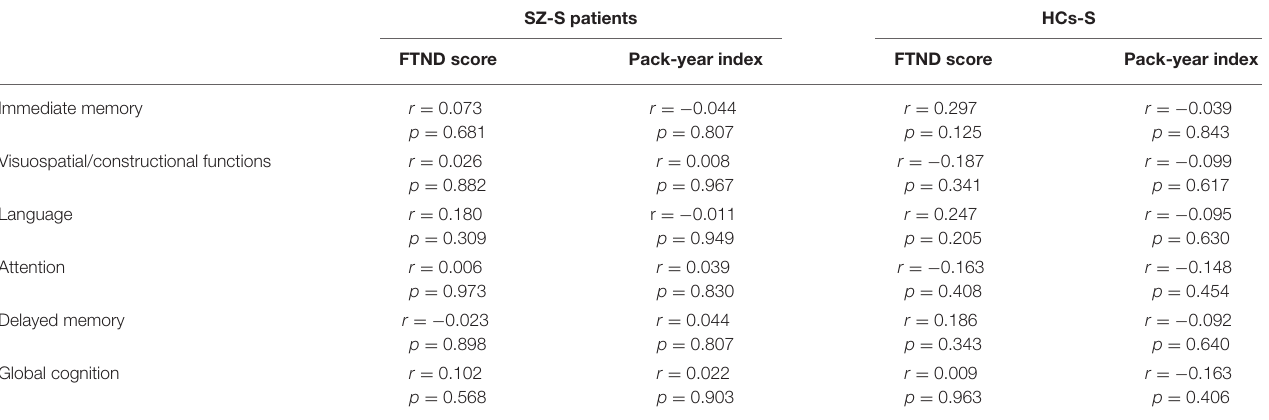
TABLE 5 | Correlations between FTND score, pack-year index cognitive performance in